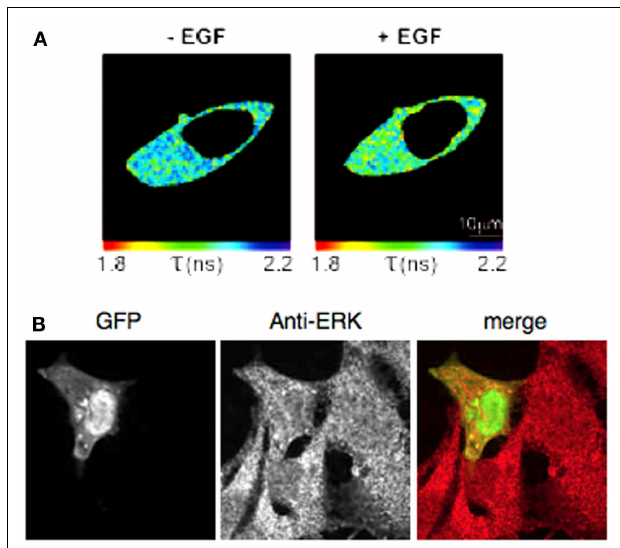
FIGUREA1 | (A) Fluorescence lifetime images of a HEK293 cell expressing cytosolic EKAR before and after (8min) addition of EGF. (B) REV- fluorescence (GFP) and ERK immunostaining (Anti-ERK) in HEK293 cells transfected with plasmids coding for cytosolic and nuclear REV